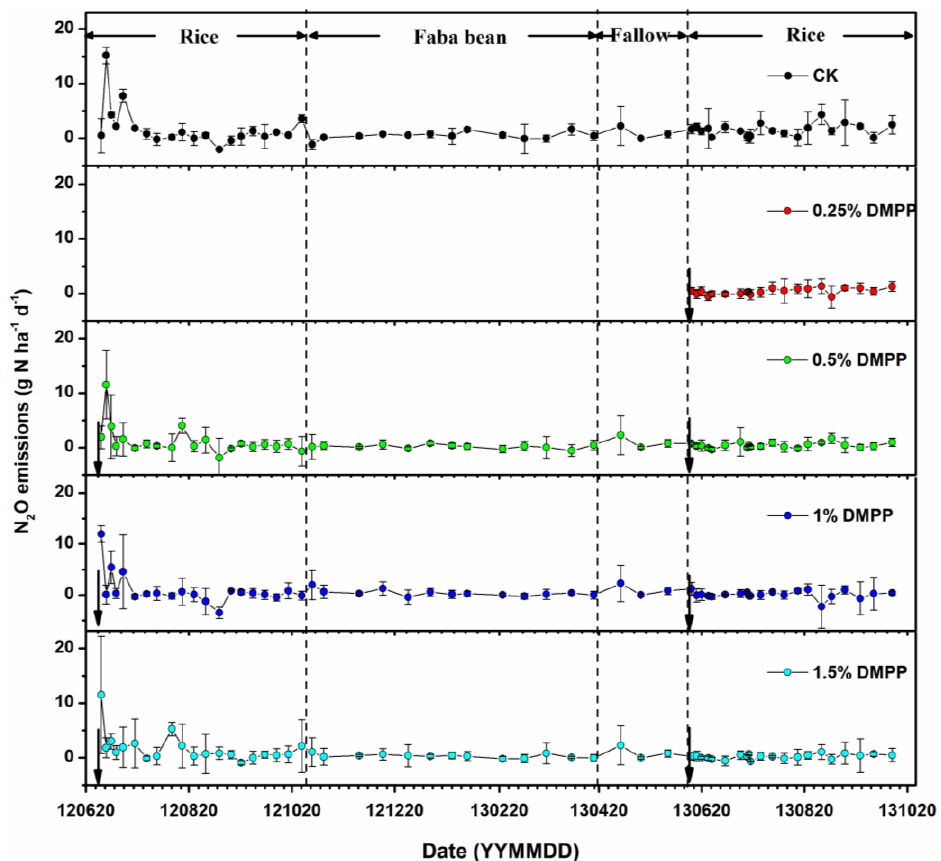
Figure 2. N 2 O emissions under different DMPP treatments.